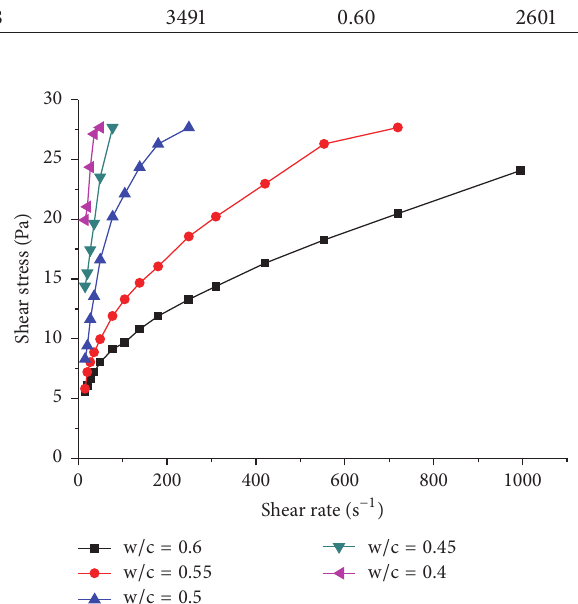
Figure 1: Effect of w/c on the rheological properties of cement